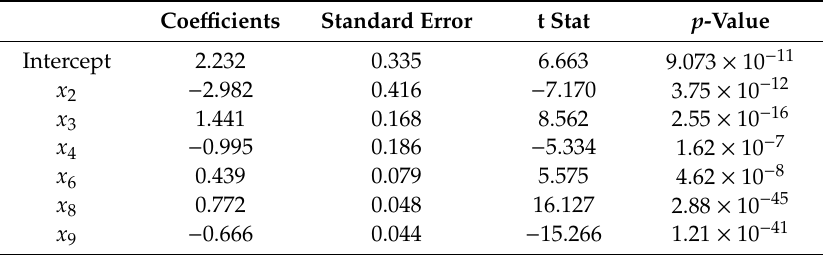
Table 7. Regression coe ffi cient.